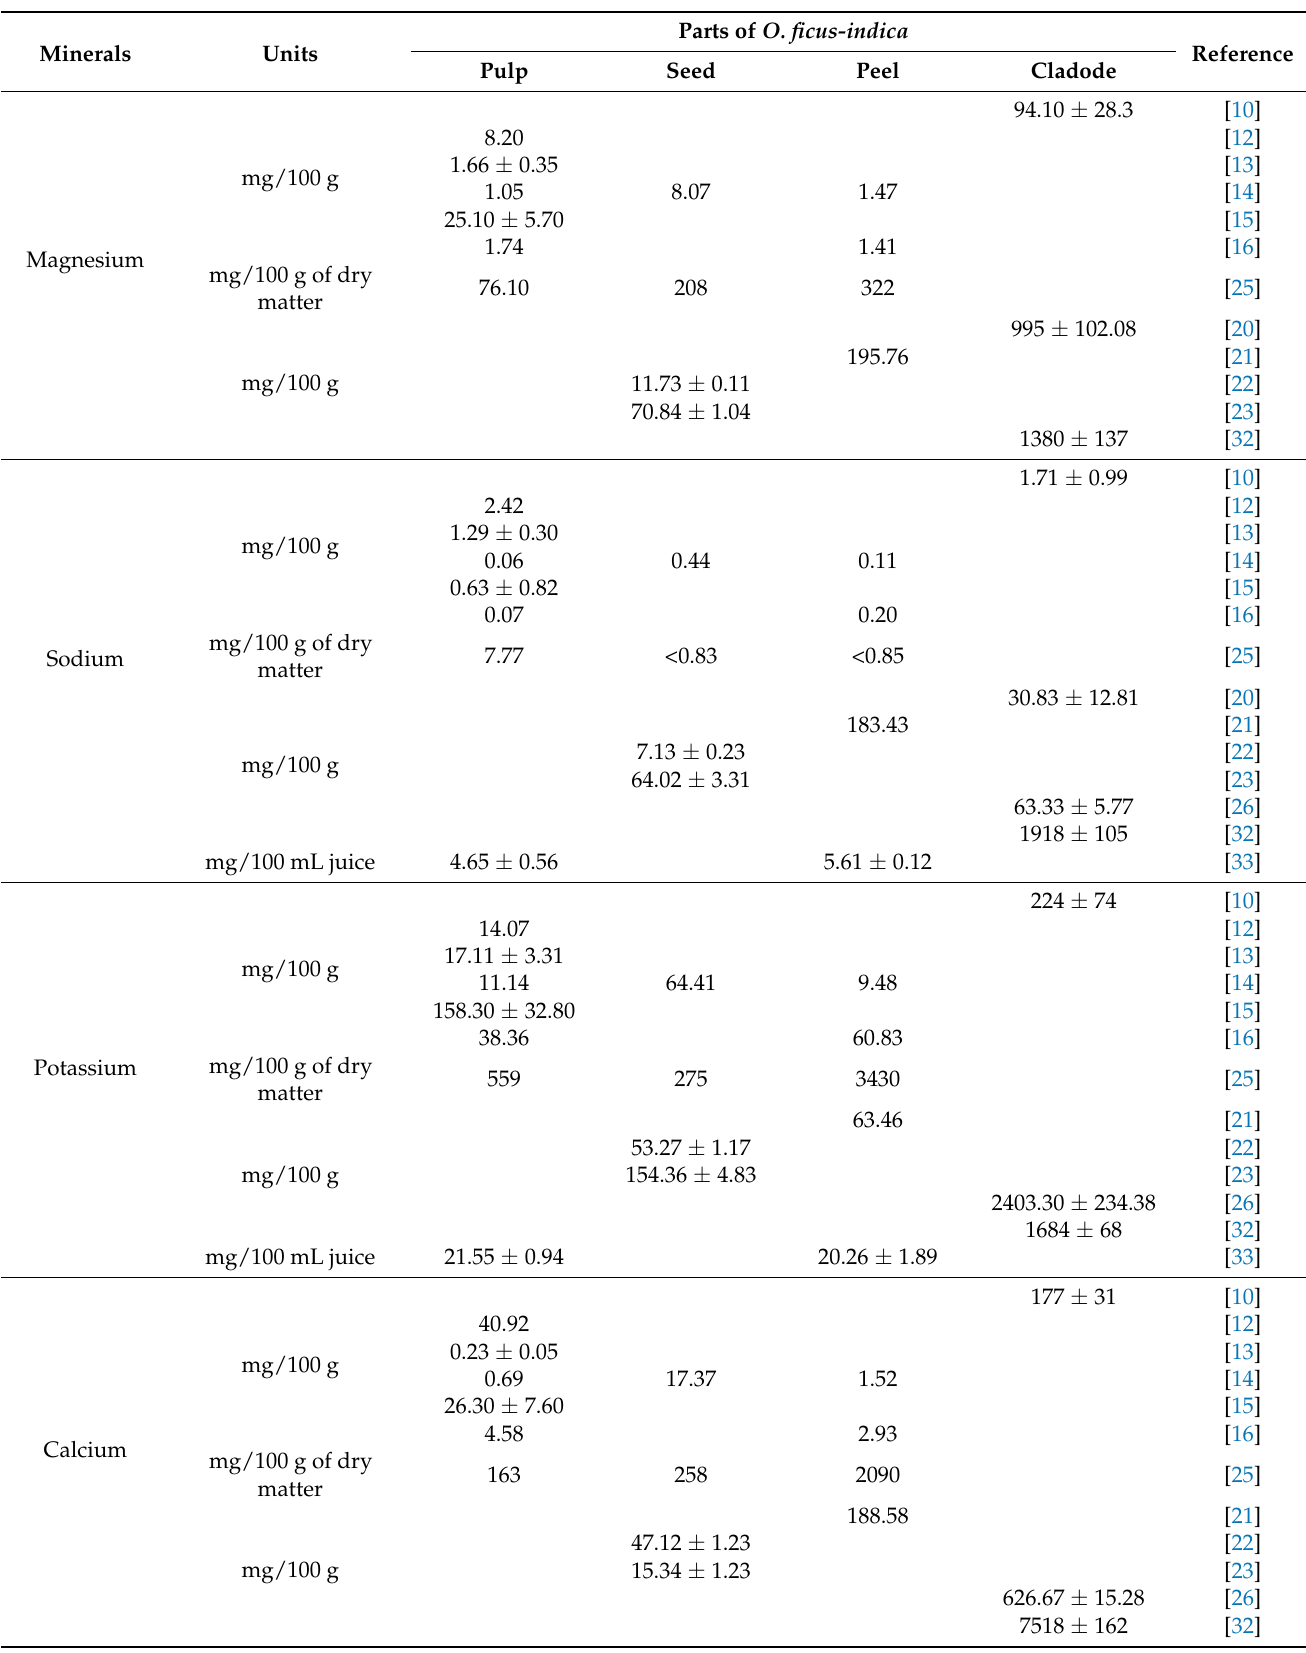
Table 2. Mineral content of the different parts of Opuntia ficus-indica (L.)